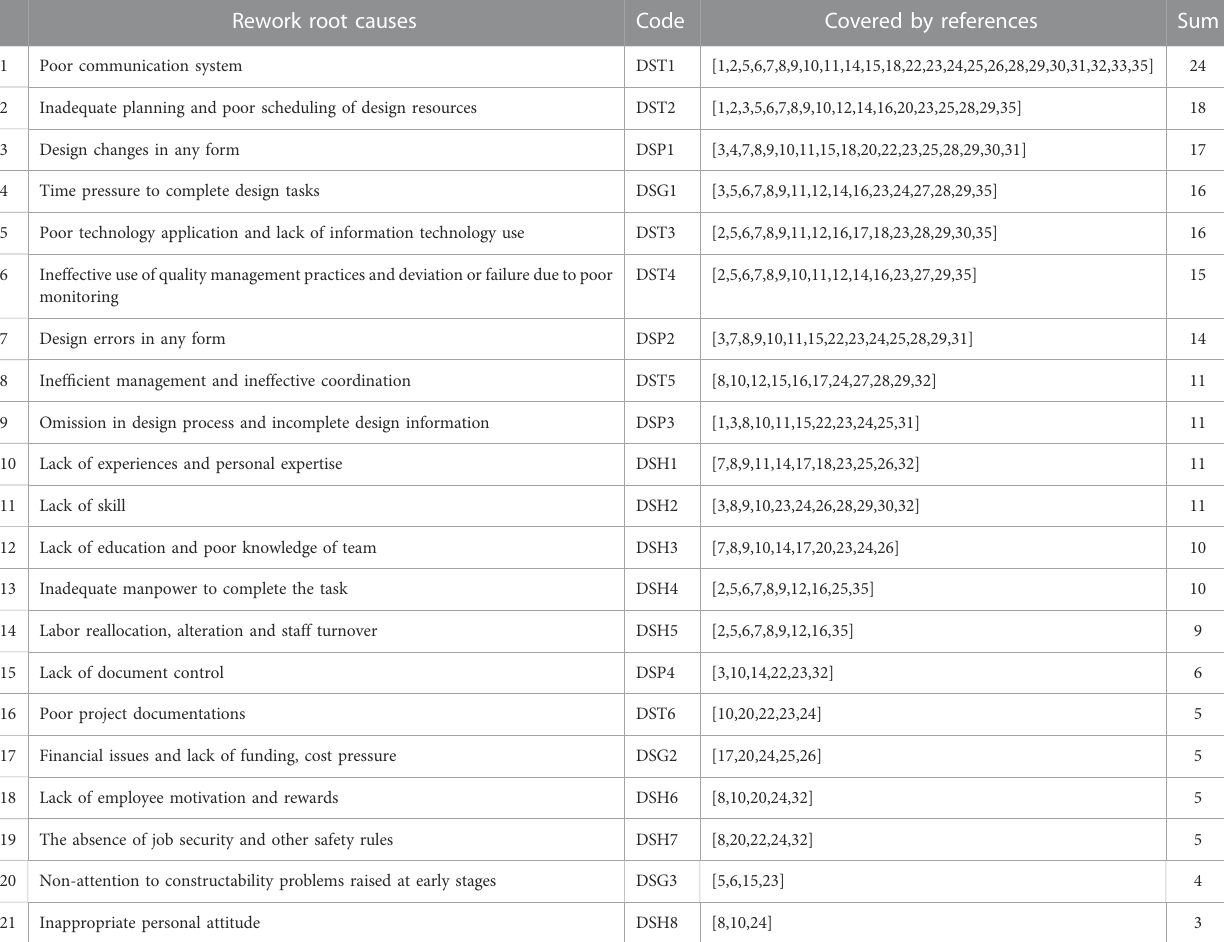
TABLE 3 Rework causes classi fi cation in design stage — liable to the contractor-side of the contract. Rework root causes Code